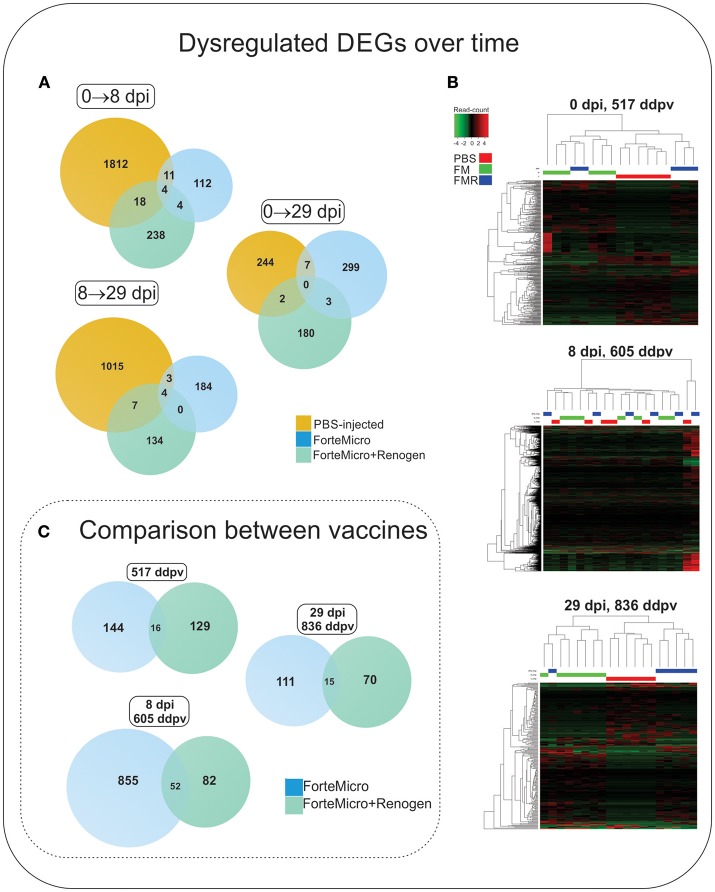
(A) Venn diagram of DEGs in Sham controls, ForteMicro® (FM)- and ForteMicro®+ and Renogen® (FM+R)-vaccinates over the time course of the study. (B) Hierarchical cluster analysis of the expression patterns of all DEGs in Sham controls, FM- and FM+R-vaccinates at each time point (p < 0.05). The expression values (TPM) shown are log2-transformed, and median-centered. Venn diagram of DEGs in FM- and FM+R-vaccinates compared to Sham controls at 517 ddpv, 8 dpi/605 ddpv, and 29 dpi/836 ddpv. (C) Venn diagram of DEGs in FM- and FM+R-vaccinates compared to controls prior to infection with A. salmonicida (517 ddpv), after infection with Asal (8 dpi, 605 ddpv), and in surviving fish (29 dpi, 836 ddpv).